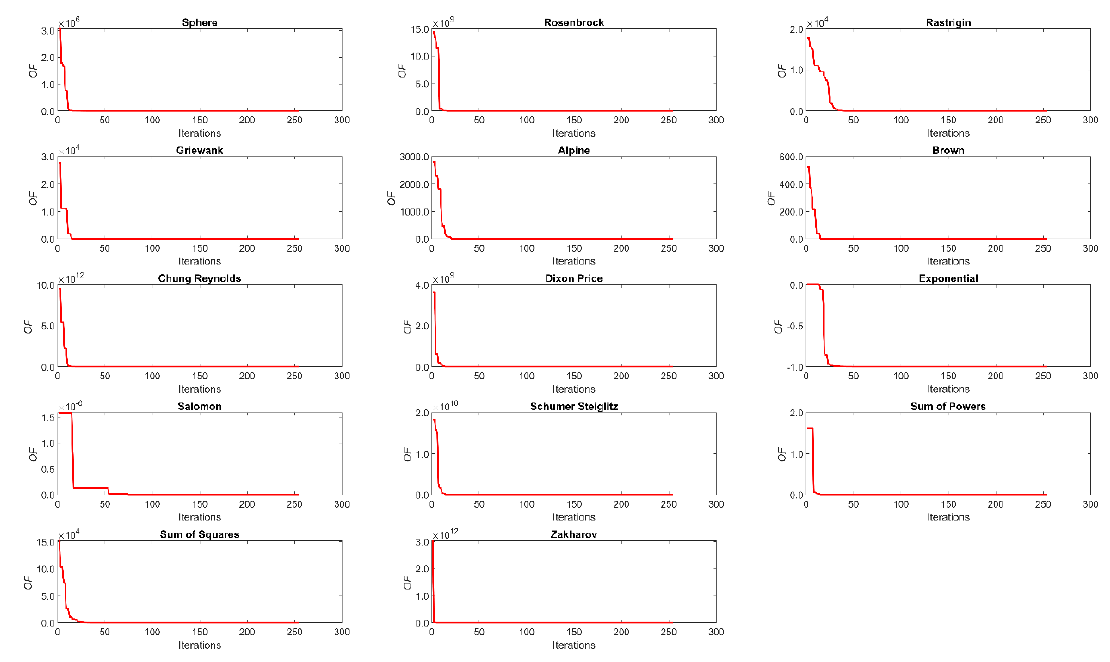
Figure 3. GTA Objective function evolution for the fourteen benchmark functions.